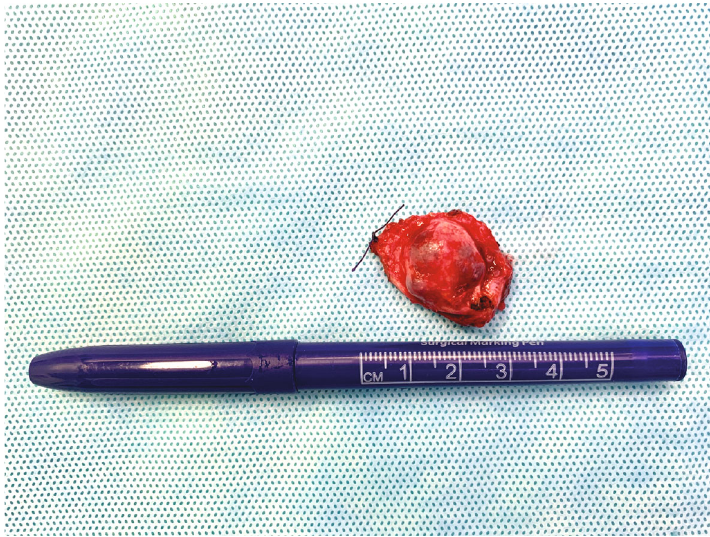
Figure 3: Image of the excised palatal tumor, with macroscopically intact capsule.